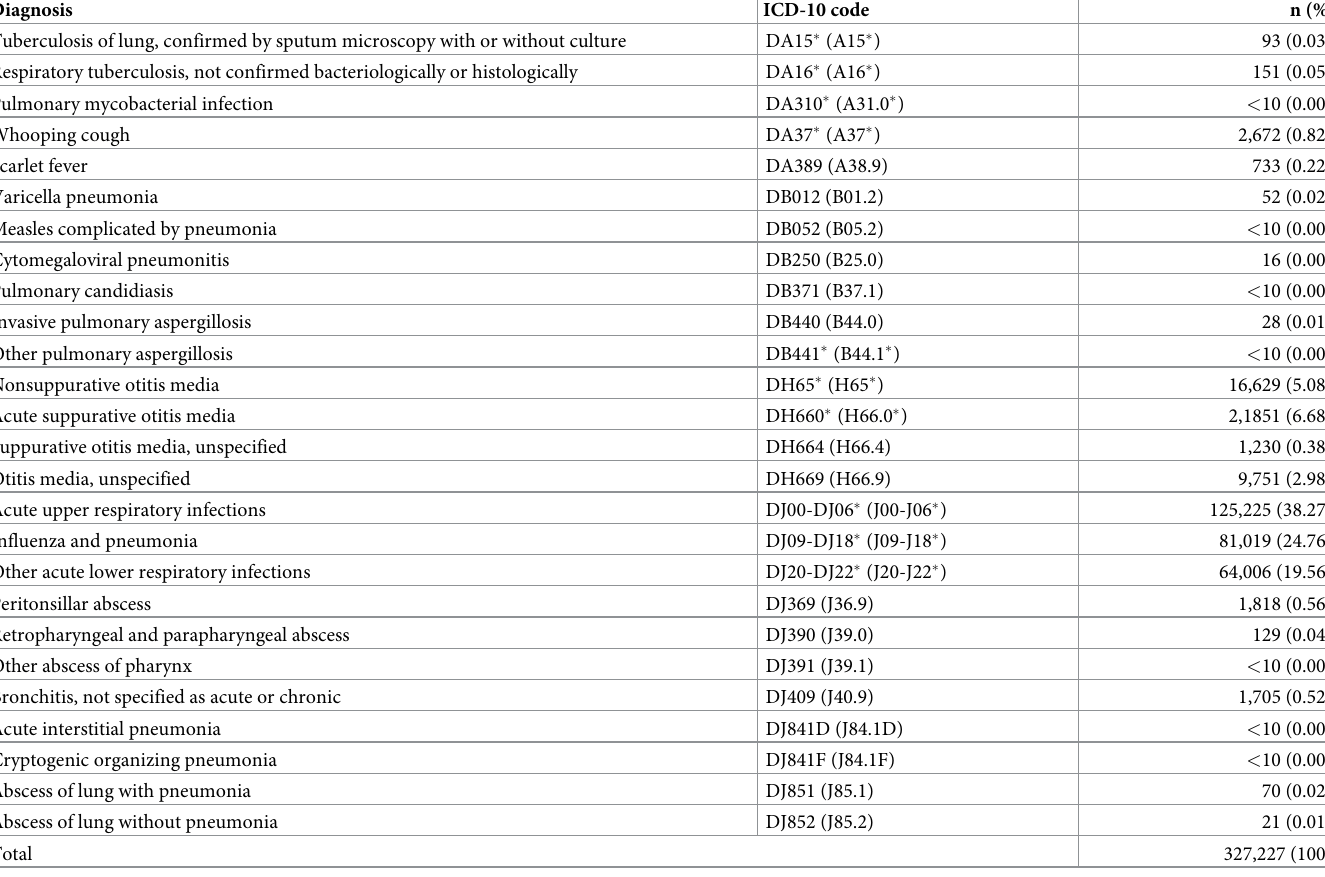
Table 1. Hospital admission diagnoses included to define outcome